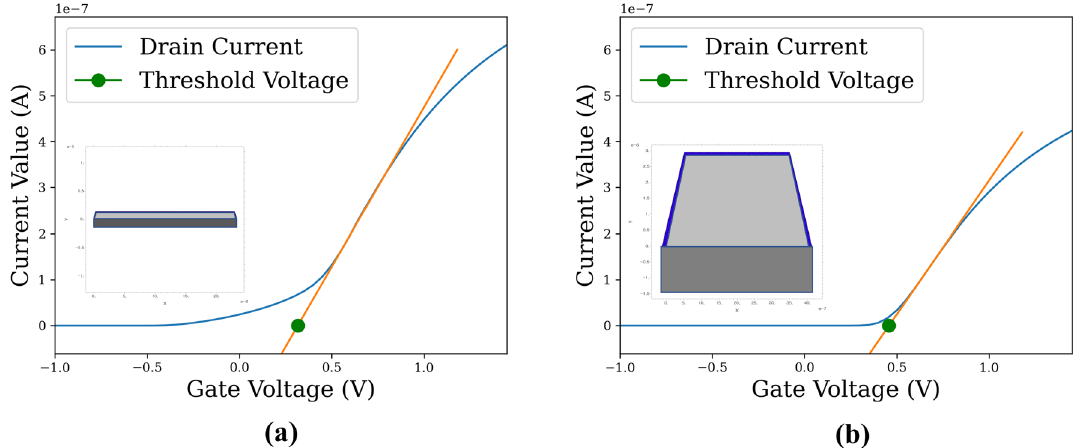
Figure 4. The I D / V G graphs of an exemplary case of inverse-design problem. ( a ) I D / V G curve of test sample with target specification; ( b ) I D / V G curve of predicted design evaluated using inverse-design